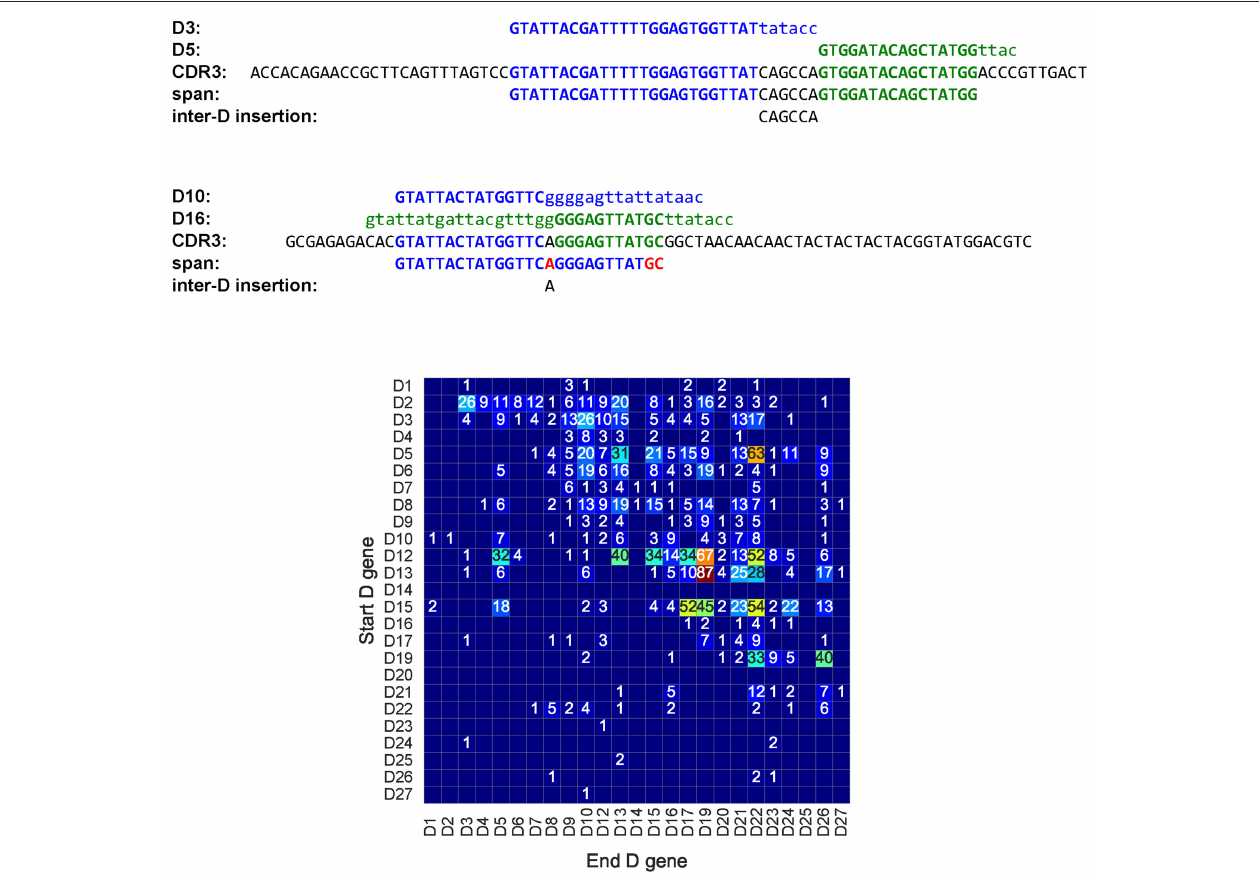
FIGURE 7 | A tandem CDR3 formed by genes D3 (IGHD3-3) and D5 (IGHD5-5) (top) , a pseudo-tandem CDR3 formed by genes D10 (IGHD3-10), and D16 (IGHD3-16) (middle) , and the tandem matrix for all tandem CDR3s across all HEALTHY datasets (bottom) . (Top) A tandem CDR3 with D match = GTATTAGGATTTTTGGAGTGGTTAT, middle = CAGCCA, and D’ match = GTGGATACAGCTATGG. (Middle) The pseudo-tandem CDR3, formed by genes D10 (IGHD3-10) and D16 (IGHD3-16). This CDR3 was formed by a single gene D10 (IGHD3-10) with three mutations (shown in red). IgScout filters out most pseudo-tandem CDR3s. (Bottom) The number in a cell ( i,j ) shows the total number of tandem CDR3s formed by genes D i and D j across all HEALTHY datasets. Empty cells correspond to pairs of D genes that do not form tandem CDR3s. Genes D4 and D5 appear in two copies in the IGH loci. The second copy of D4 (IGHD4-11) appears between D10 (IGHD3-10) and D12 (IGHD5-12). The second copy of D5 (IGHD5-18) appears between D17 (IGHD4-17) and D19 (IGHD6-19). The vast majority of tandem CDR3 correspond to cells in the upper half of the matrix. The only populated column in the lower part of the tandem matrix corresponds to the D5 gene and likely results from tandem CDR3s formed by the second copy of D5 in the IGH